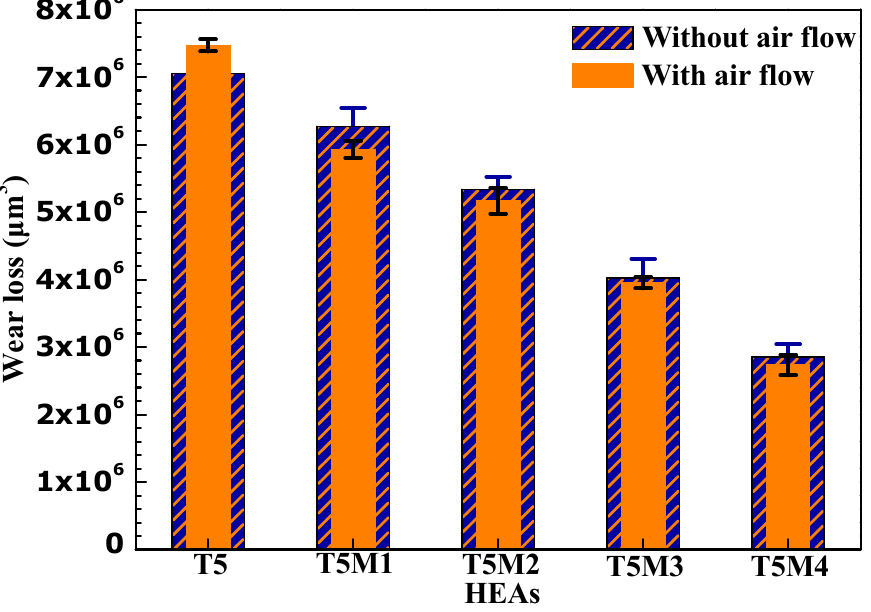
Figure 9. Wear volume loss of AlCrFeNiTi 0.5 Mo x over a sliding distance of 45 m with and without air flow.